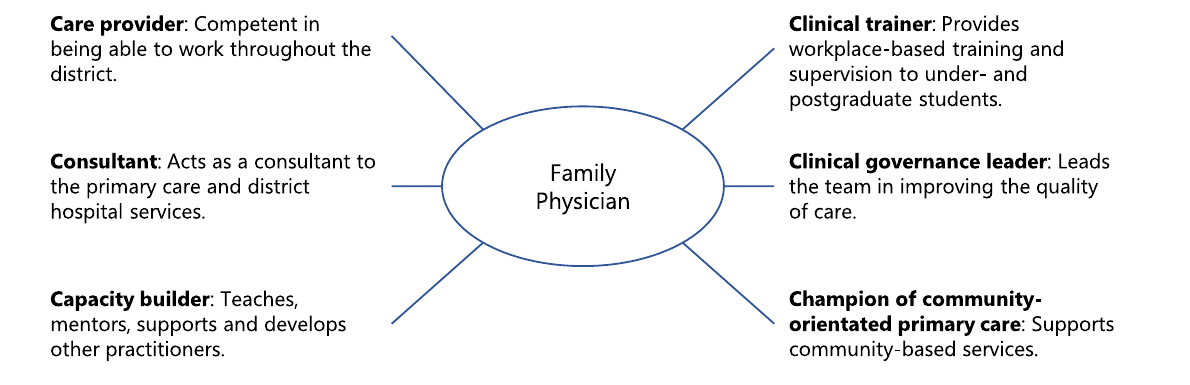
Figure 1: Six roles of the South African family physician.